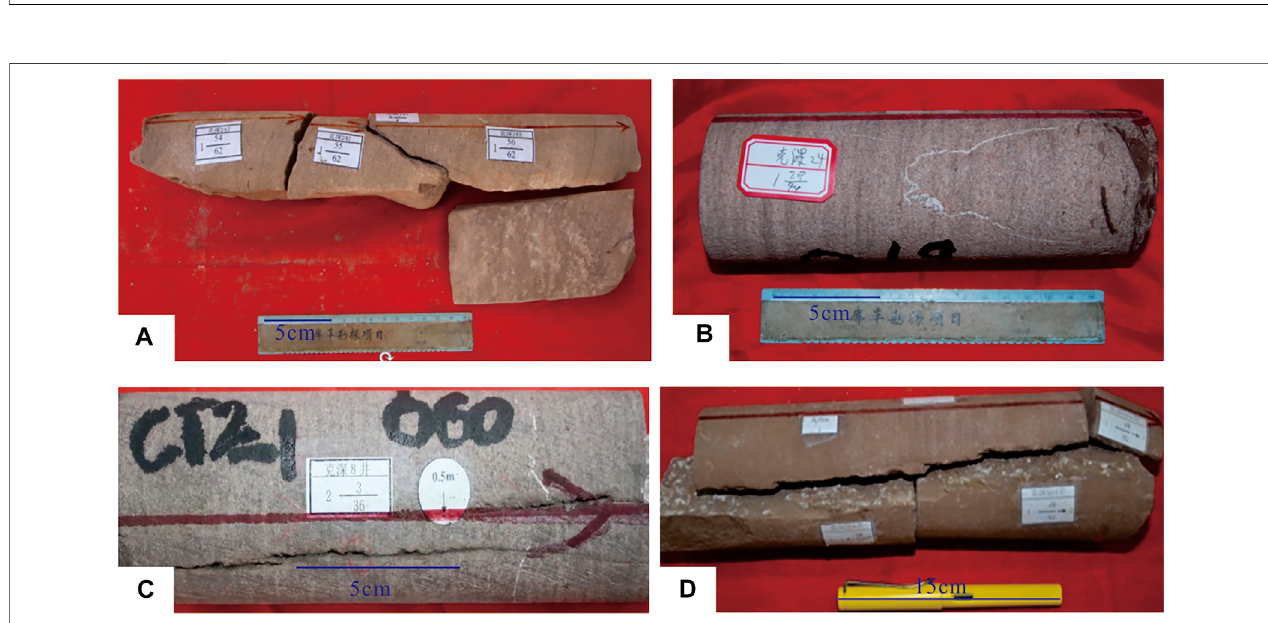
FIGURE 4 | (A) Well ks242, K 1 bs, 6,451.5 m, Medium sandstone, it can be seen that high angle fracture and vertical fracture intersect obliquely; (B) Well ks24, K 1 bs, 6,179.2 m, a medium high angle fracture fi lled with calcite; (C) Well ks8, K 1 bs, 6,737.5 m, opened high angle fractures; (D) Well ks8, K 1 bs, 6874 m, half- fi lled vertical fracture.